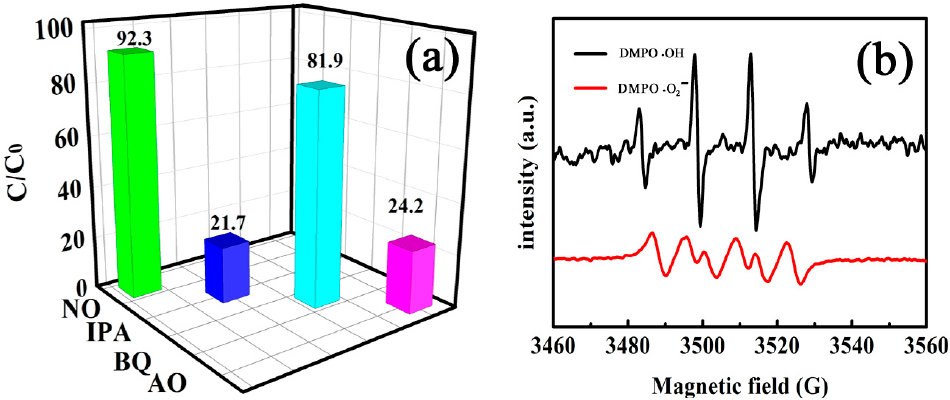
Figure 13. ( a ) Effect of radical scavengers on RhB degradation and ( b ) ESR spectra of DMPO ‐ •OH and DMPO ‐ •O 2 − de ‐ tected in the system of MnFe 2 O 4 /BGA ‐ H 2 O 2 under visible